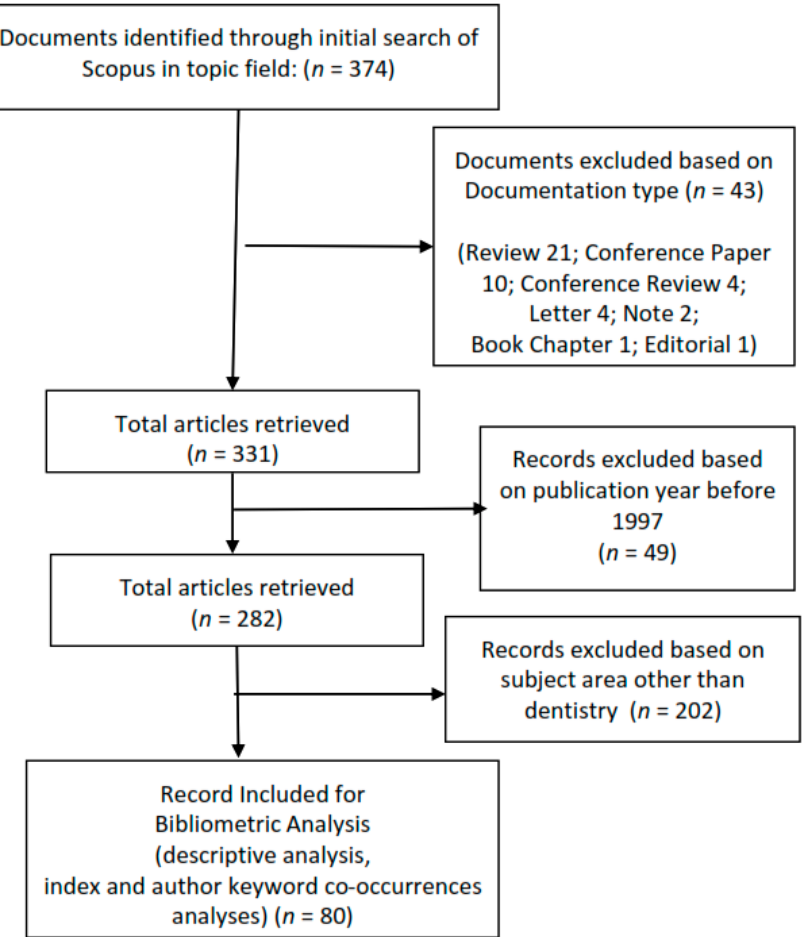
Figure 1. PRISMA flow charts of procedures used in the identification of final article for the bibliometric review.